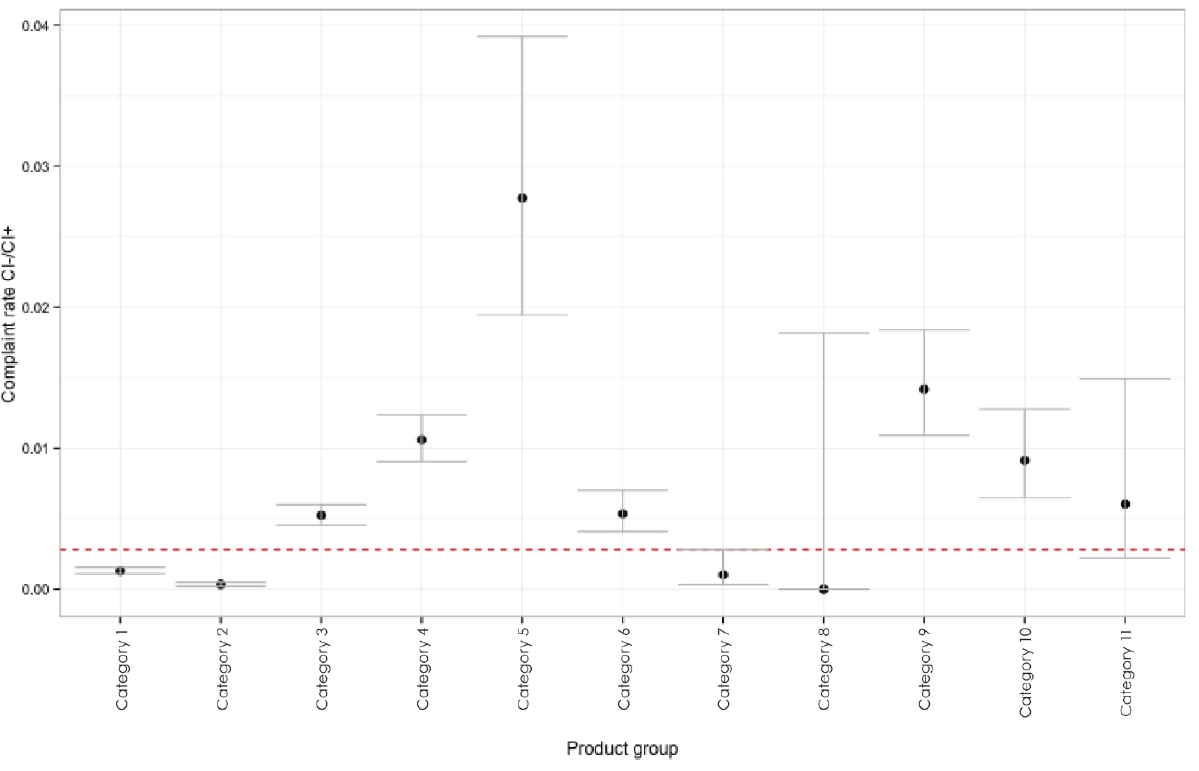
Figure 1. Product complaint rates for each category (presented as dots) together with 95% confidence intervals and the overall return rate (presented as dashed line). Table 2. Grouping of various implant designs based on the treatment protocol (immediate loading, two-stage, etc.) and surface properties (rough vs. polished